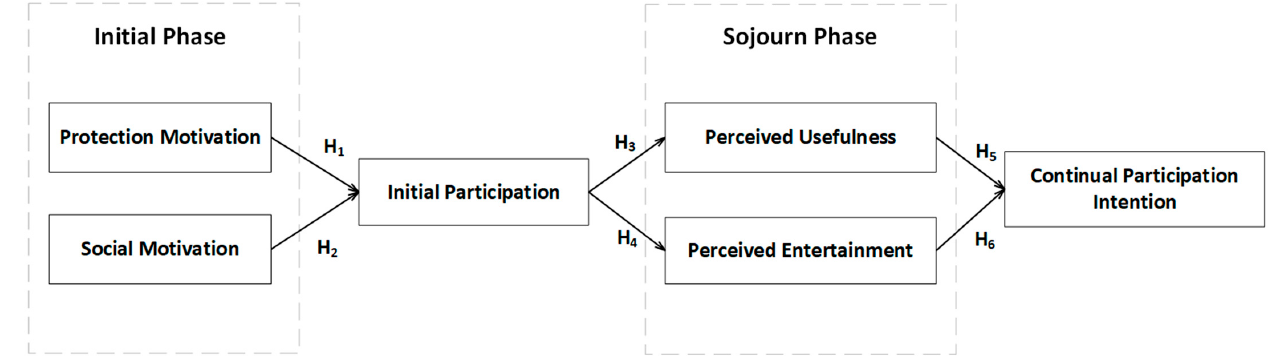
Figure 1. Research